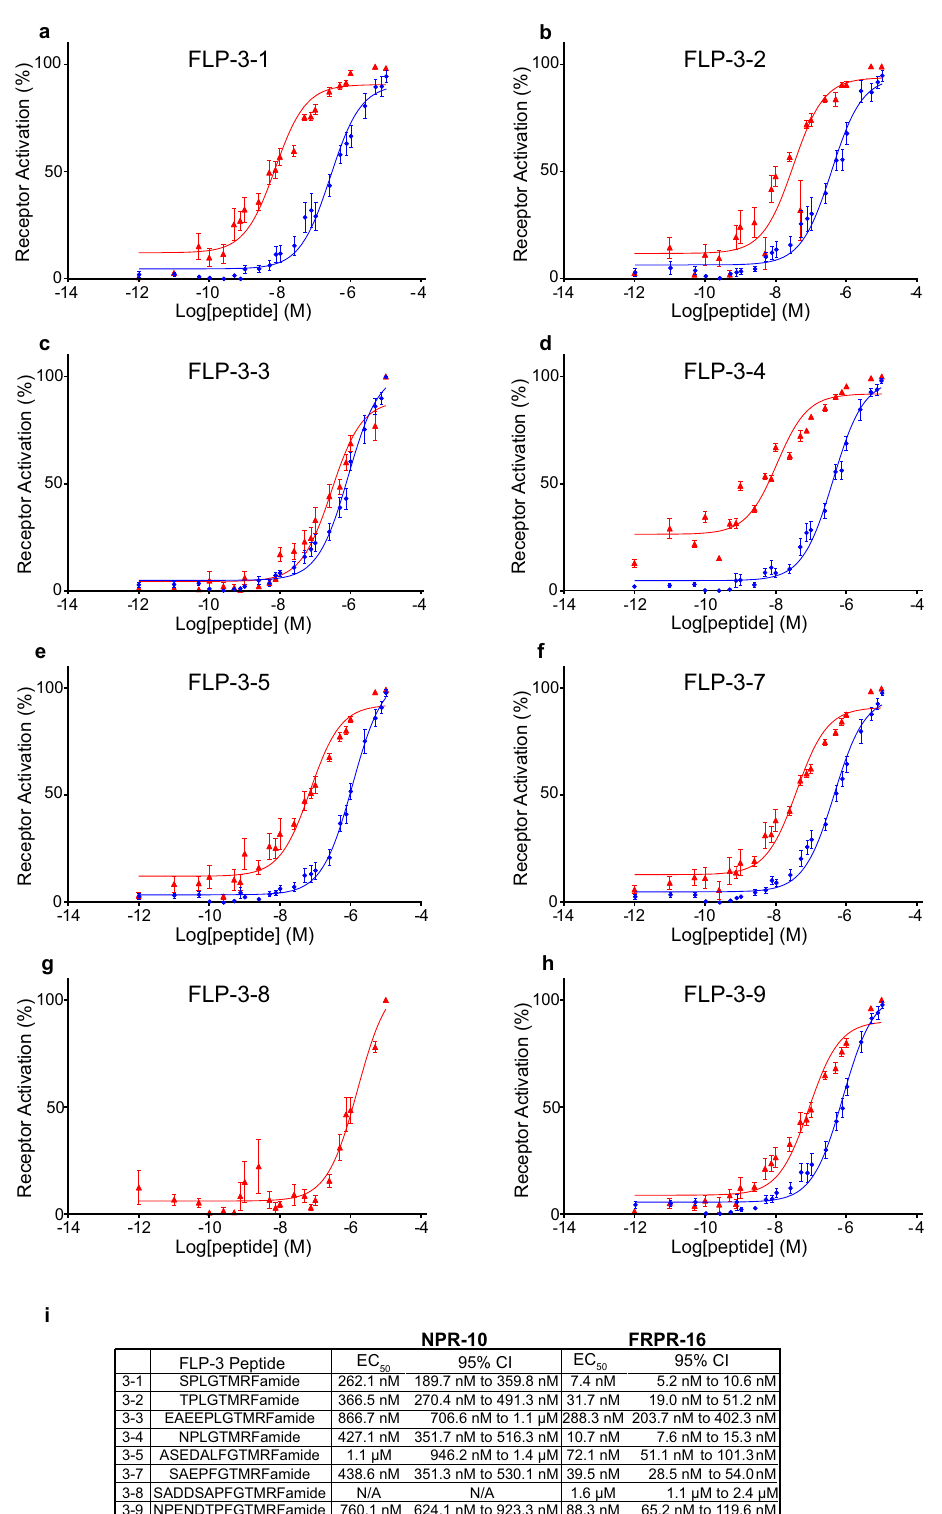
Fig. 4 FLP-3 peptides activate two different G protein-coupled receptors, NPR-10 and FRPR-16, in vitro. Dose response curves of a FLP-3-1, b FLP-3-2, c FLP-3-3, d FLP-3-4, e FLP-3-5, f FLP-3-7, g FLP-3-8, and h FLP-3-9 for activation of NPR-10B (blue circles) and FRPR-16 (red triangles). Peptides FLP-3-6 and FLP-3-10 did not activate either receptor. i EC 50 values and 95% Con fi dence Intervals for FLP-3 peptide activating NPR-10B and FRPR-16. a – h Error bars denote SEM. n ≥